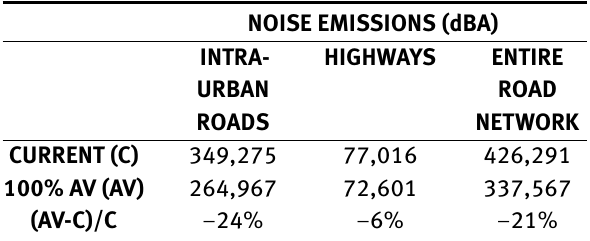
Table 3: Noise emissions comparison: 100% AV and current